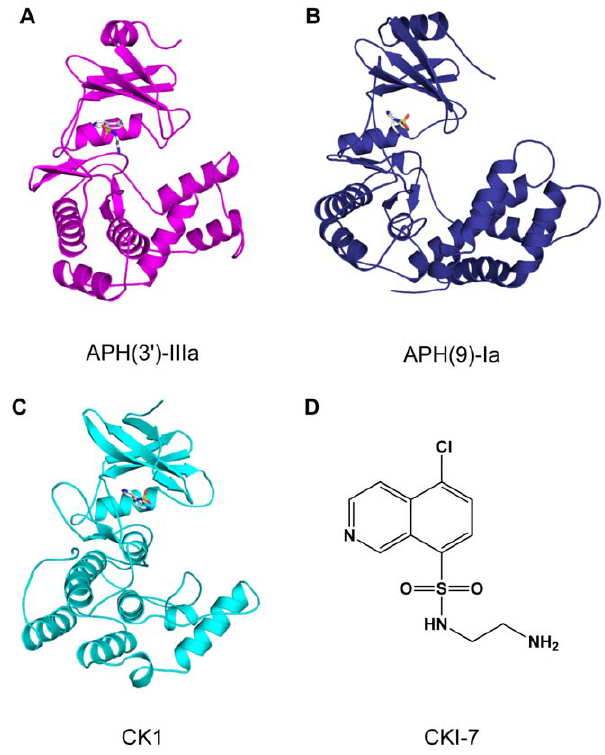
Figure 1. Crystal structures of CKI-7-bound kinases. (A) APH(3 9 )- IIIa, (B) APH(9)-Ia, and (C) CK1 (PDB 2CSN). The enzymes are shown in cartoon representation and the inhibitors are drawn as sticks. (D) Chemical structure of